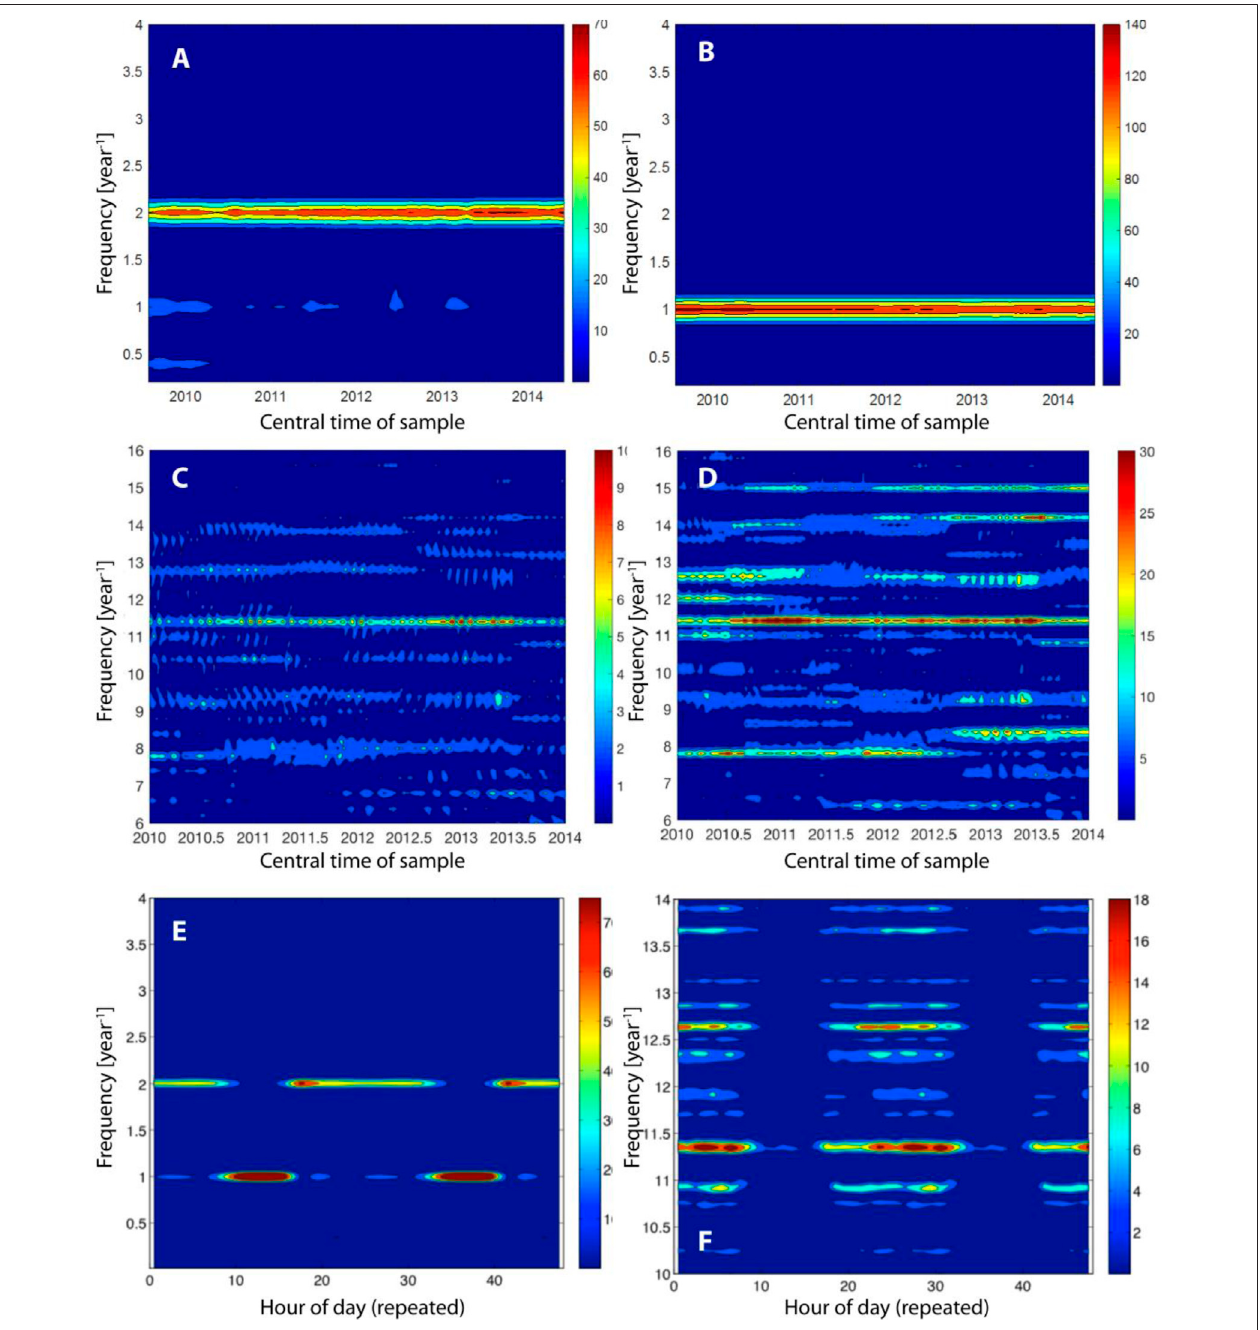
FIGURE 3 | (A) Spectrogram formed from noon-time GSI c measurements, using a sliding window of length 150 days. There is a strong feature at 2 year − 1 , and a comparativelyweakfeatureat1 year − 1 . (B) SpectrogramformedfrommidnightGSI c measurements,usingaslidingwindowoflength150days.Thereisastrongfeature at1 year − 1 . (C) Spectrogramformedfromnoon-timeGSI c measurements,usingaslidingwindowoflength150days.Thereisonlyaweakfeatureatabout11.4 year − 1 . (D) Spectrogram formed from midnight GSI c measurements, using a sliding window of length 150 days. The strongest feature is at about 11.4 year − 1 . We fi nd weakertransientfeaturesatabout9.4 year − 1 and8.4 year − 1 . (E) Powerspectrumasafunctionofhourofdayforthefrequencyrange0 – 4 year − 1 .Notethatthedominant feature is an “ island ” centered on noon at 1 year − 1 . (F) Power spectrum as a function of hour of day for the frequency range 10 – 14 year − 1 . Note that the dominant features are “ islands ” at frequencies 11.4 year − 1 and 12.6 year − 1 centered near 3 am.